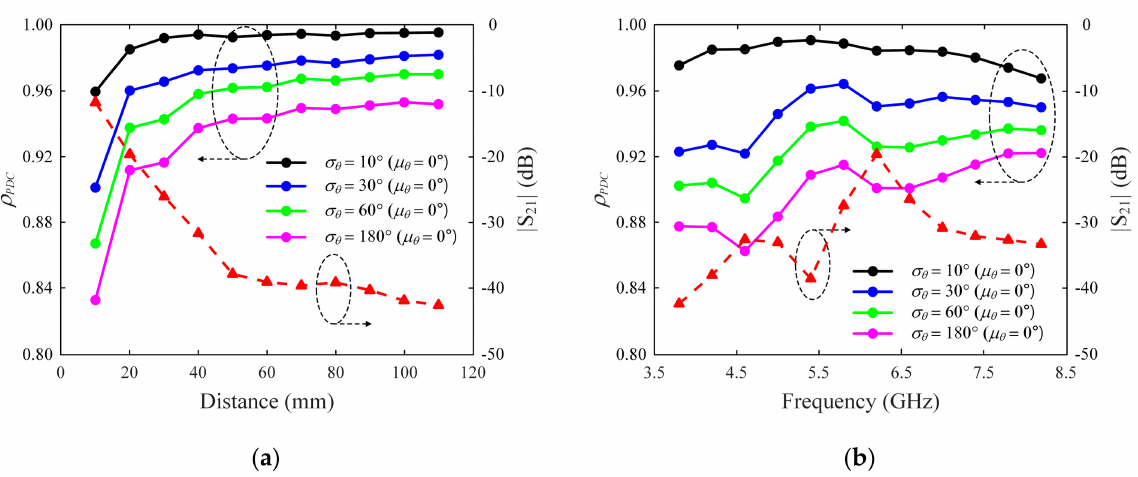
Figure 3. Simulated variation in ρ PDC and |S 21 | for patch antenna according to ( a ) the distance at 6 GHz and ( b ) frequency (distance = 20 mm).